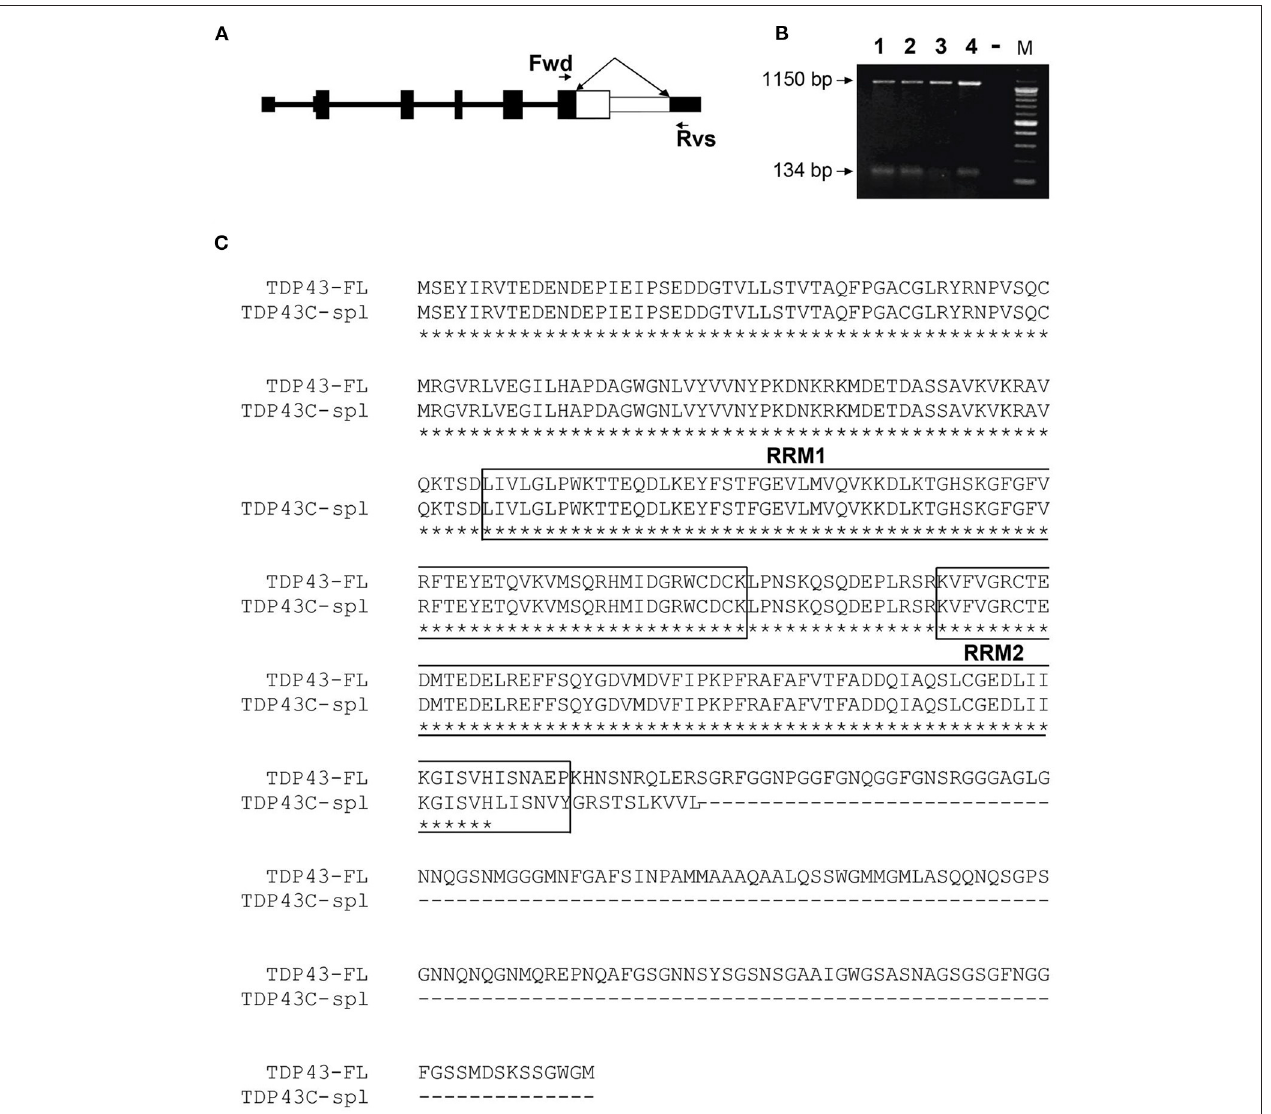
FIGURE 2 | Identification of a human TDP-43 splice variant using RT-PCR. (A) Representation of the gene structure of full length TDP-43. The forward (Fwd) primer in CDS of exon 6 and reverse (Rvs) primer in the 3 ′ UTR in exon 6 are indicated by arrows. The white area in exon 6, indicated by the double-headed arrow, represents the region that is spliced out in TDP43C-spl. (B) A major higher RT-PCR product of 1,150 bp, corresponding to the human full-length TDP-43 (TDP43-FL), was amplified from RNA isolated from Lane 1, human brain; Lane 2, human spinal cord; Lane 3, human dorsal root ganglion and Lane 4, SHSY5Y cells. The lower band represents a cluster of exon 6 splice variants, with DNA sequencing identifying TDP43C-spl, with a 1,020 bp deletion generating a RT-PCR product of 134 bp. (C) Sequence alignment of TDP43-FL and TDP43C-spl. The two RNA-recognition motifs (RRM1 and RRM2) in TDP43-FL are mostly conserved in TDP43C-spl (boxed). A unique 16 aa sequence (LISNVYGRSTSLKVVL) is generated at the C-terminus of TDP43C-spl.